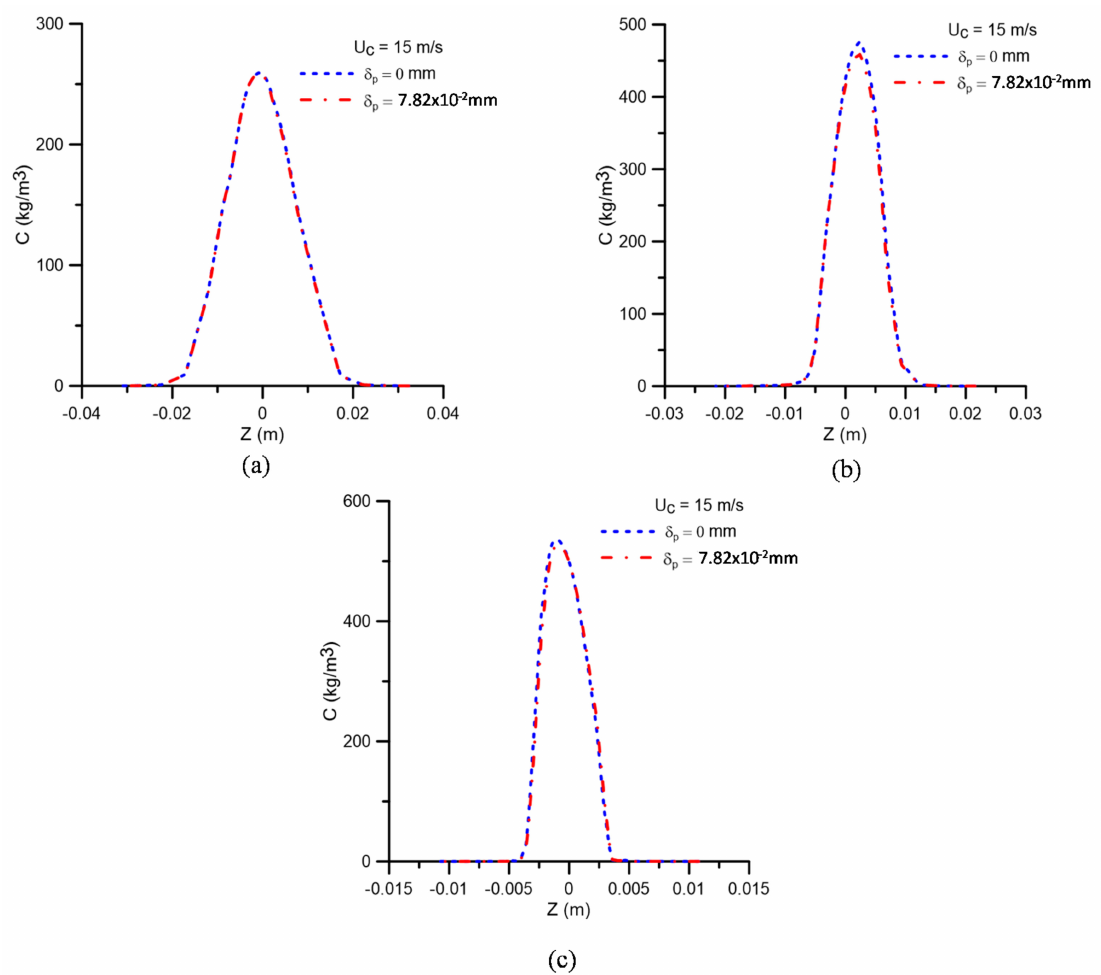
Figure 6. Oil concentration profiles in the positions: ( a ) y = 0.15 m; ( b ) y = 0.45 m, and ( c ) y = 0.75 m, with δ p = 0, δ p = 7.82 × 10 − 2 mm, and f o =